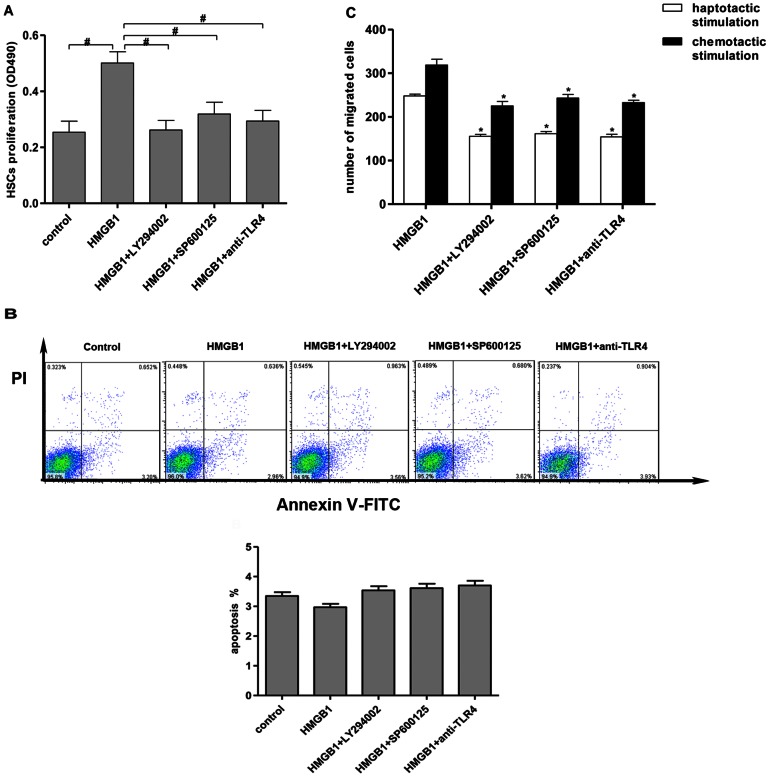
TLR4-dependent JNK and PI3K/Akt were involved in HMGB1-induced HSCs proliferation and migration.A: The proliferation of HSCs pretreated with SP600125 (JNK inhibitor) or LY294002 (PI3K/Akt inhibitor) or TLR4 neutralizing antibody for 1 h was analyzed after their incubations with HMGB1 for 24 h by MTT assay. # P<0.05, compared with the HMGB1group. B: The apoptosis of HSCs was analyzed by flow cytometry and Annexin V-FITC+PI- represented the HSCs apoptosis as shown in the upper part. The apoptosis percent was calculated and shown by the bar chart. C: After pretreatment with SP600125 (JNK inhibitor) or LY294002 (PI3K/Akt inhibitor) or TLR4 neutralizing antibody, the HSCs migration was significantly inhibited compared with those stimulated only with HMGB1 no matter by haptotactic or chemotactic mechanism. *P<0.05, compared with the HMGB1 group stimulated in the same way (haptotactic or chemotactic stimulation). Data in subfigures A–B are both presented as mean ± SEM (n = 6).